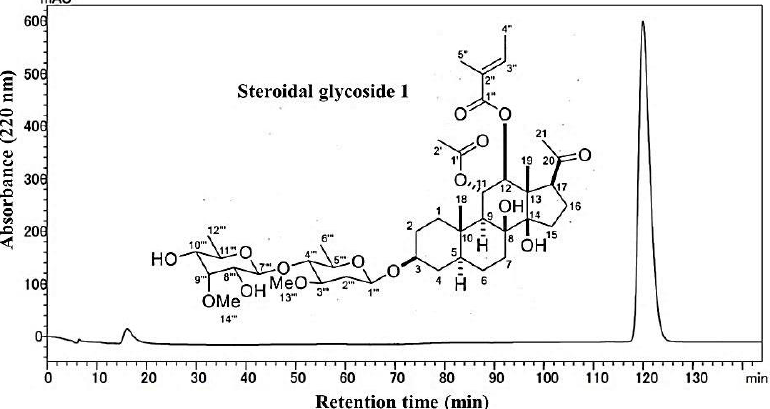
Figure 4. HPLC chromatogram and molecular structure of compound 1.